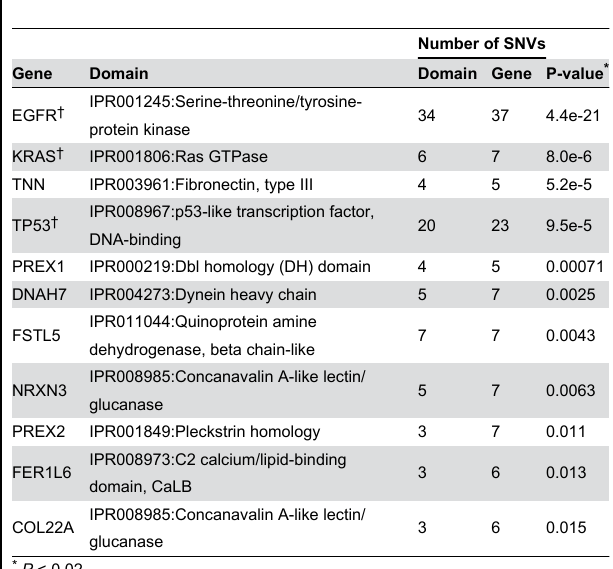
Table 1. List of the identified possible cancer-related